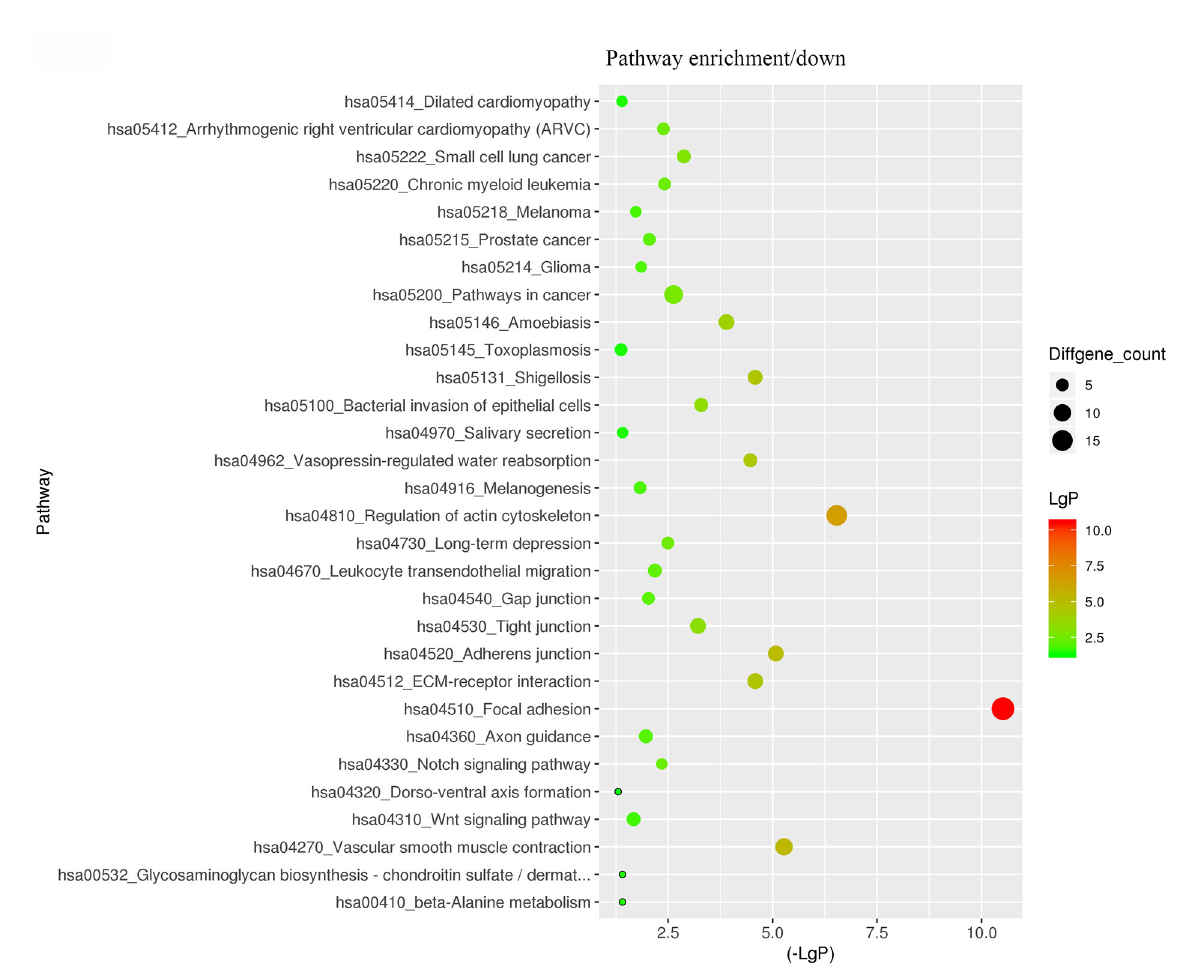
FIGURE6 KEGG Pathway analysis of differentially expressed genes based on the KEGG database. And KEGG pathways enrichments of down-regulated genes. The x-axis represents the negative logarithm of the p -value (-Lg P). The larger the value, the greater the significant difference of this pathway. The size of the bubble represents the number of differentially expressed genes in the